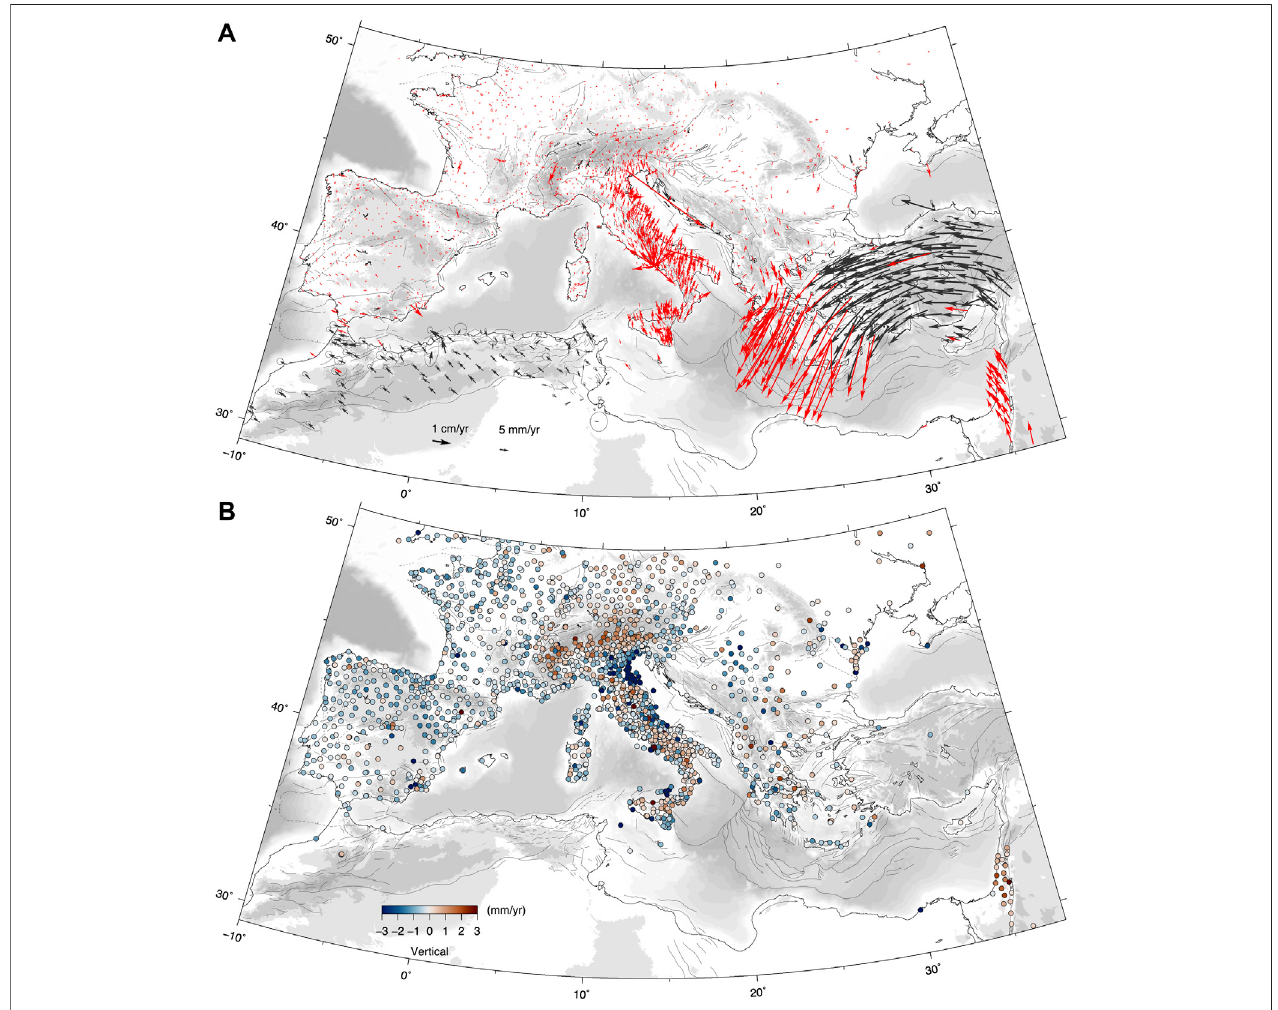
FIGURE 6 | Horizontal (A) and vertical (B) velocities. The red arrows in A represent horizontal velocities, with the black arrows refer to horizontal velocities of continuous GNSS stations from published velocity fi elds, that provide a kinematic framework for northern Africa and Anatolia, where no freely accessible GNSS RINEX data are available, to our knowledge. Blue and red circles in B show negative (subsidence) and positive (uplift) vertical ground motion rates. The maps contain some “ anomalous ” velocity values, with respect to the mean trends, that must be considered as non-tectonic outliers.